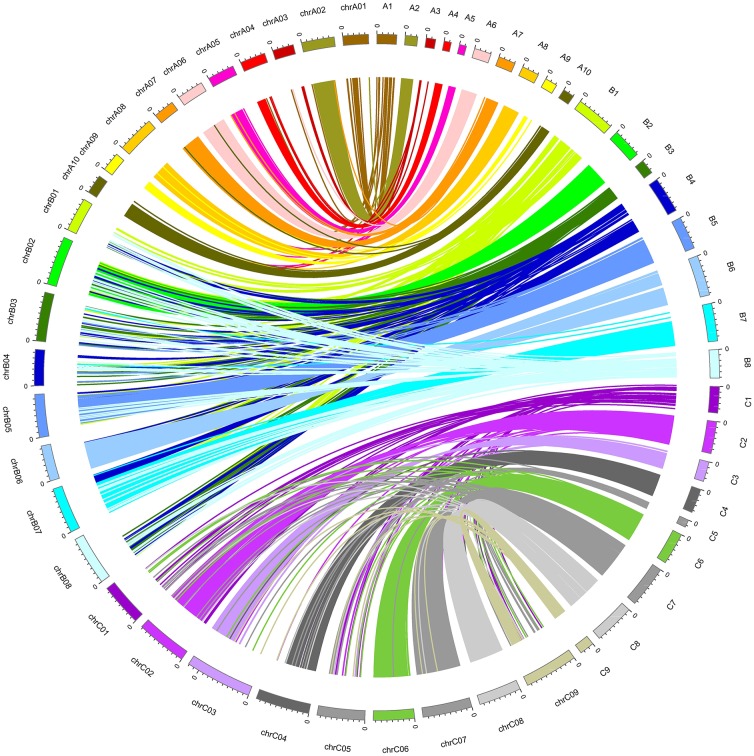
Collinearity between the genetic map (A1–A10, B1–B8, C1–C9) and the physical map (chrA01-chrA10, chrB01-chrB08, chrC01-chrC09).